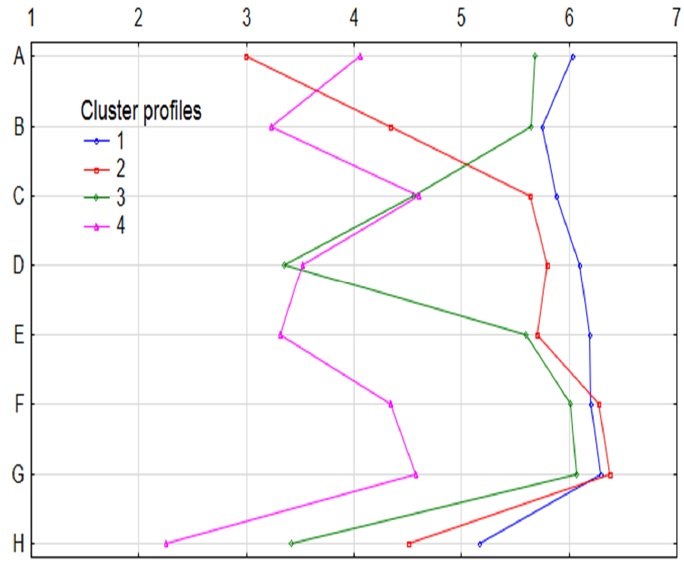
Figure 1. Profiles and frequency of using the canteen offer. 1—daily, 2—2 or 3 times a week, 3—once a week, 4—2 or 3 times a month, 5—once a month, 6—sporadically, 7—never; A. soups, B. main